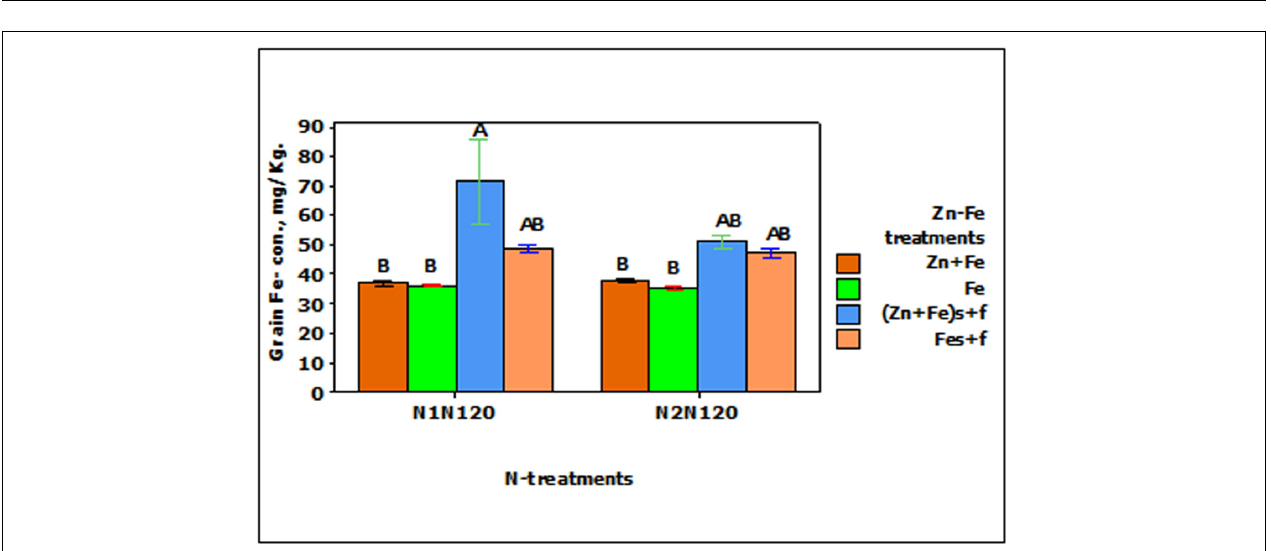
FIGURE 3 | Mean ± 1 SE ( n = 4) bar plot of grain Fe- concentration for the effect of Zn–Fe- treatments. N1 and N2 stand for single and split application of N. N120 stands for 120 kg N ha − 1 . Zn + Fe and Fe without suffix for growth media application and with suffix s + f for growth media plus foliar application. Bars with same alphabet at head are not significantly different at 5% level of